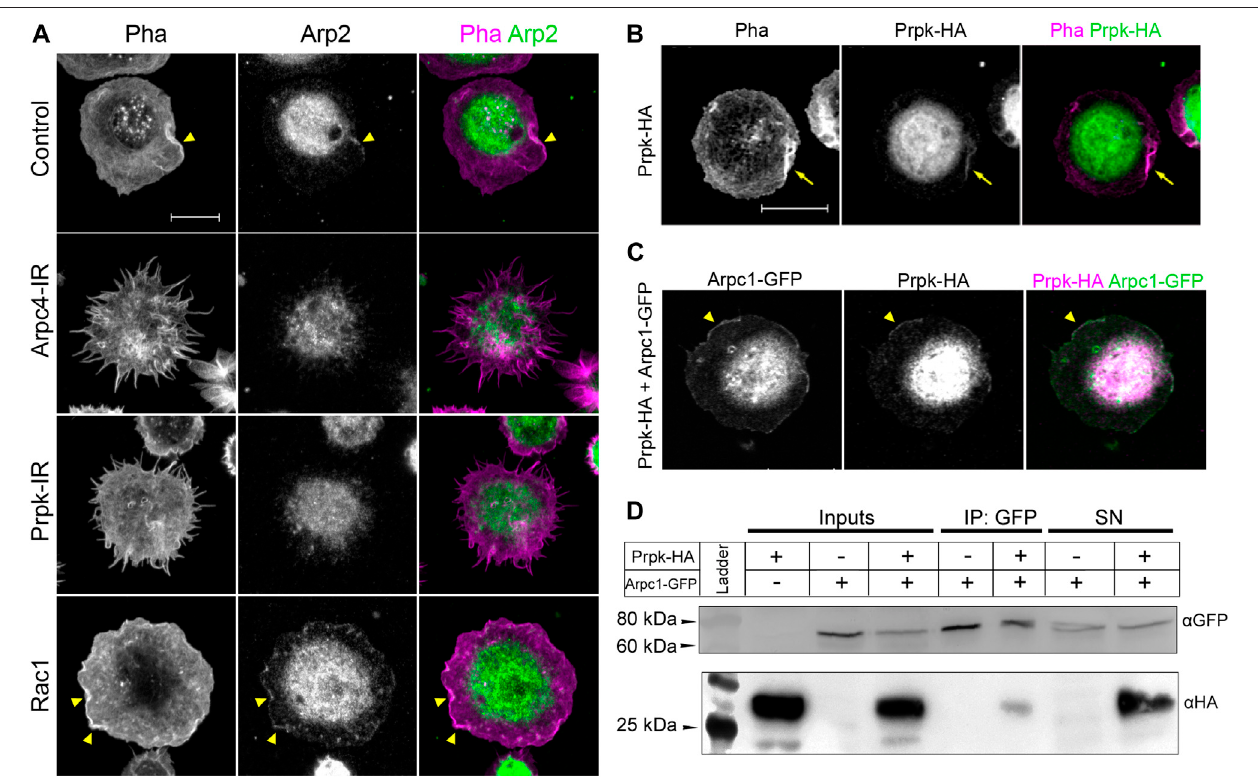
FIGURE 3 | Prpk colocalize with Arp2/3 complex and physically interacts with Arpc1 subunit. (A) Immuno fl uorescence against Arp2 subunit (Arp2, green) of primary culture of hemocytes expressing: Cg-Gal4 driver (Control), Arp2/3 p20 subunit RNAi (Arpc4-IR), Prpk RNAi (Prpk-IR) and Rac1 GFPase (Rac1) using Cg-Gal4 driverineachcondition.F-actinwasstainedwithphalloidin(Pha,magenta).Arrowheadindicateslamellipodia-likeruf fl es. (B) Immuno fl uorescenceofculturedhemocytes stained for F-Actin (Pha, magenta) and overexpressing Prpk-HA (green). (C) Immuno fl uorescence of hemocytes overexpressing Prpk-HA and Arpc1-GFP. Arrowhead indicates co-localization in lamellipodia-like ruf fl es (D) Co-immunoprecipitation between Prpk-HA and Arpc1-GFP. Inputs, Immunoprecipitation and Supernatants (SN) conditions are detailed in each case. The image corresponds to a representative blot, n = 2. Constructs expression was induced using the Cg-Gal4 driver for each condition. Scale bars: 10 μ